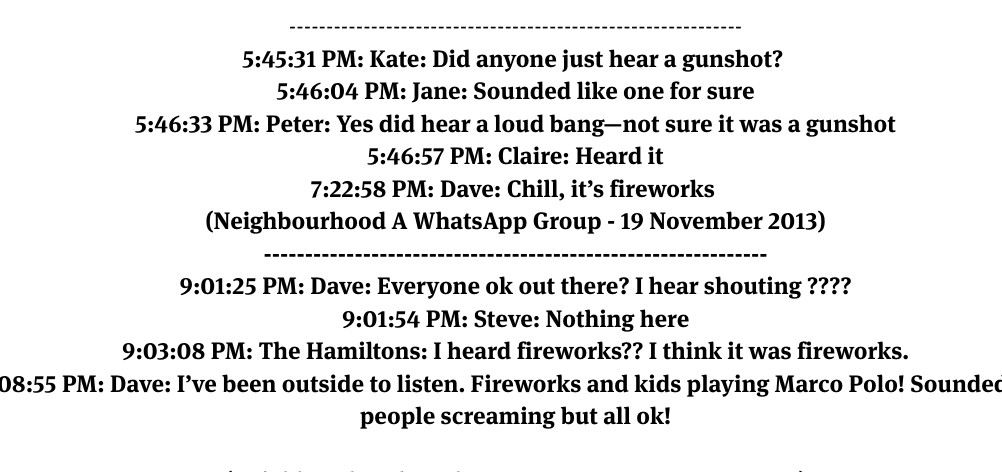
Figure 2. Extracts from a WhatsApp exchange in Neighbourhood